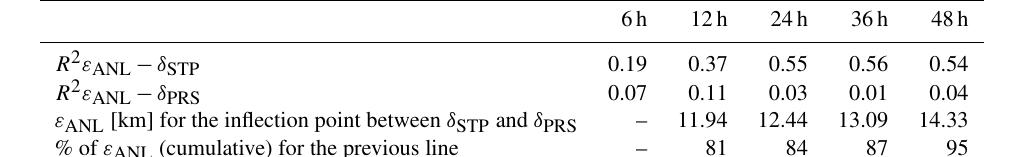
Table 2. Correlation coefficient values between the best ε ANL and δ STP and between ε ANL and δ PRS after 6, 12, 24, 36, and 48h of simulation.